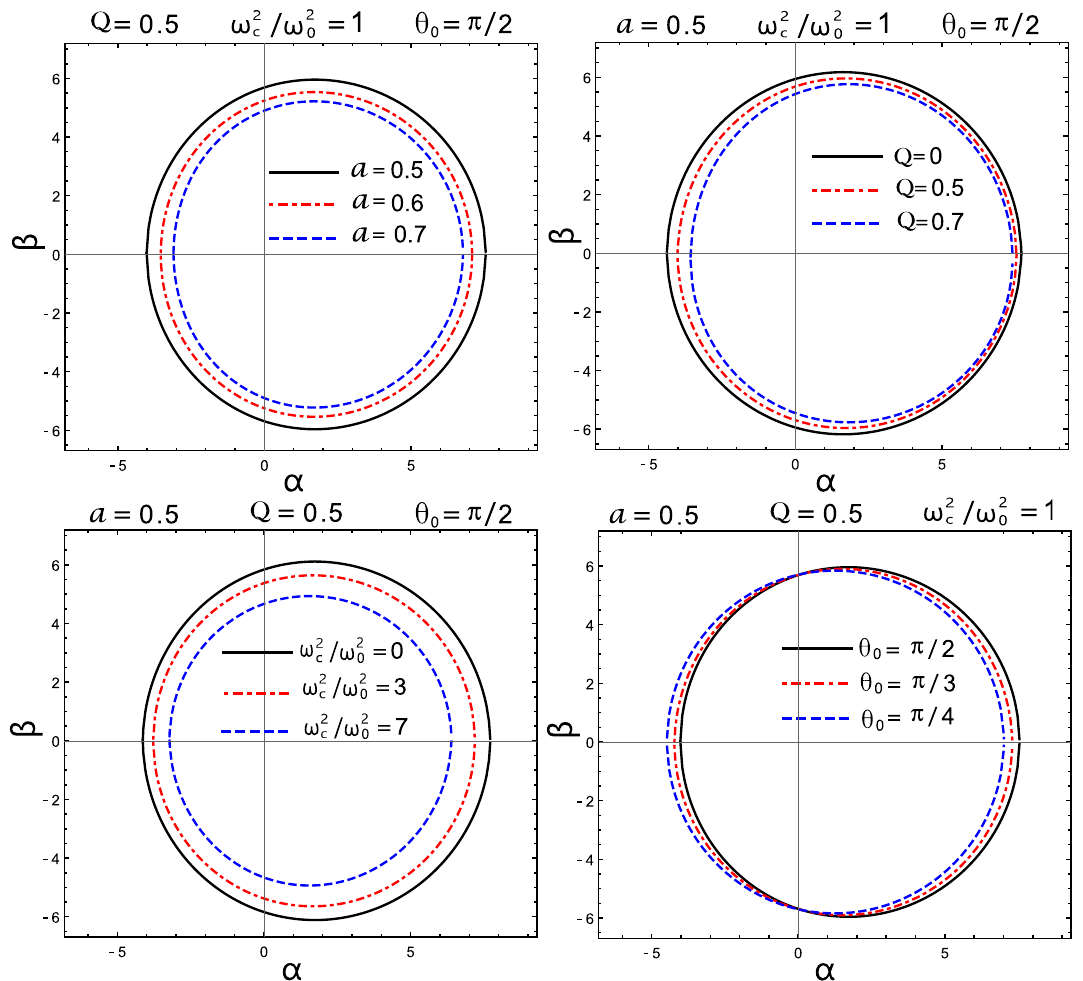
Fig. 1 The variation of the spin, charge, plasma and inclination parameters, sequentially, shows the shadow of a Kerr–Newman black hole √ M 3 r , when viewed by a local surrounded by a Shapiro-like plasma distribution f ( r ) = ω 2 c